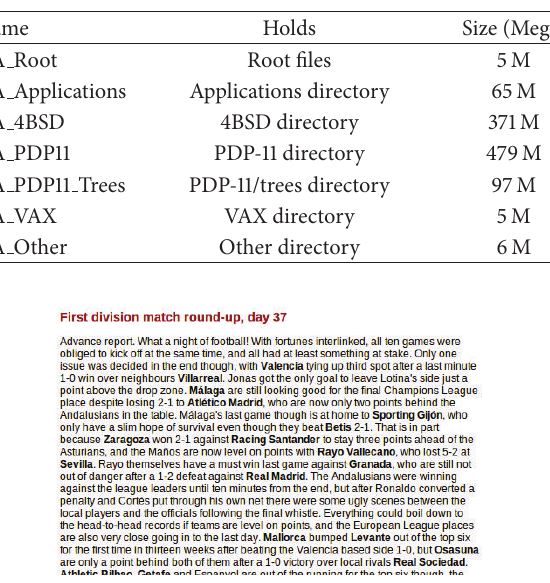
Table 1: An example of a table object.